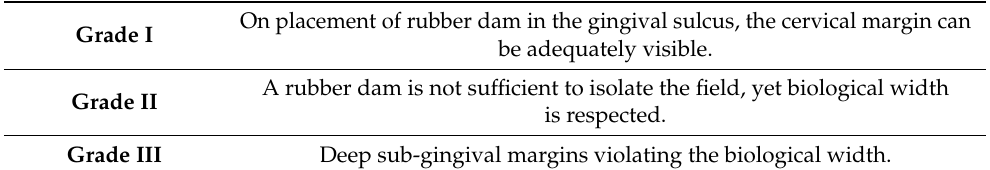
Table 2. Classification of adhesive restorations with sub-gingival margins based on technical operat- ing and biological